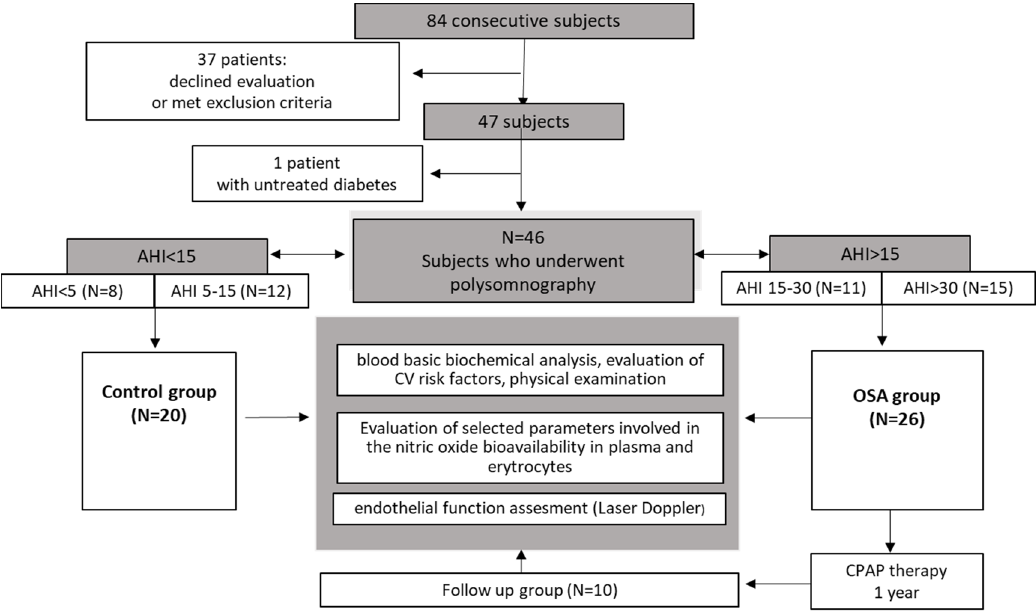
Figure 2. A flow chart of the study protocol. Abbreviations : OSA: Obstructive sleep apnea; AHI: apnea hypopnea index; CV: cardiovascular; CPAP: continuous positive airway pressure.